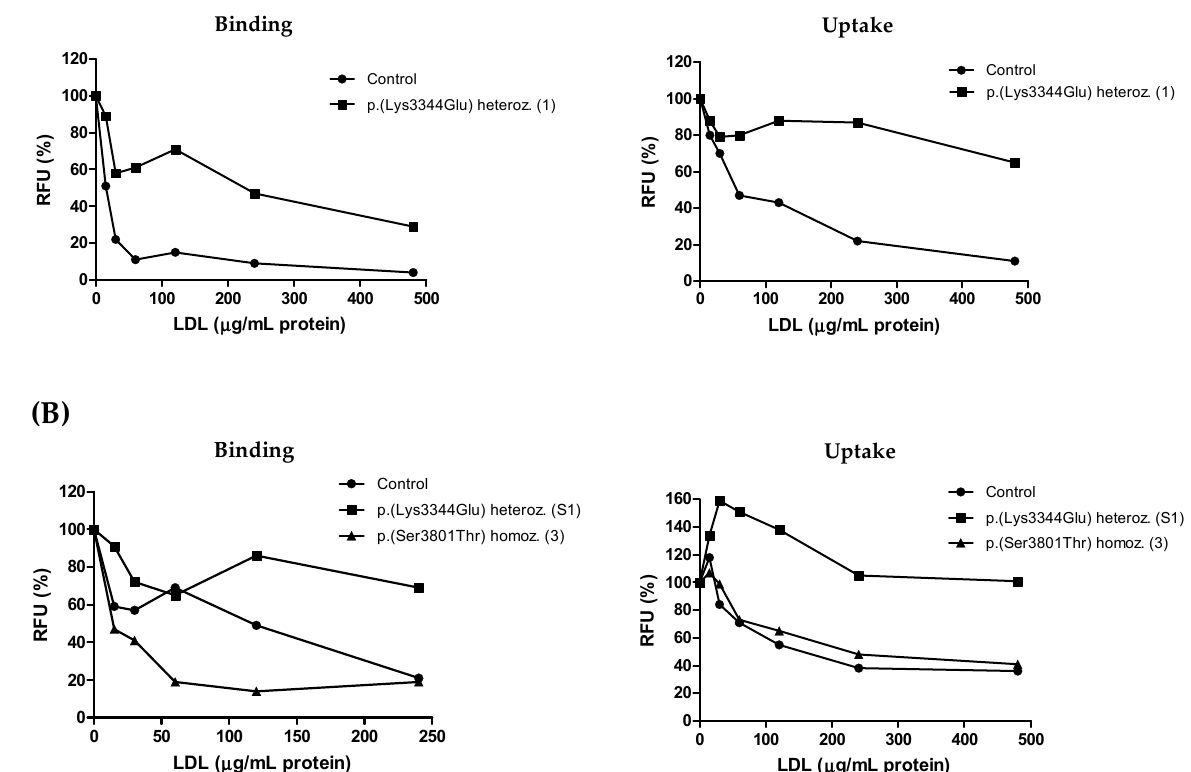
Figure 3. Competitive binding and uptake of LDL in HepG2 cells. ( A ) Ability of LDL from apoB p.(Lys3344Glu) heterozygous patient 1 and the control to compete with DiI-LDL for cellular binding ( p < 0.001) and uptake ( p = 0.014). ( B ) Ability of LDL from apoB p.(Lys3344Glu) heterozygous patient S1, apoB p.(Ser3801Thr) homozygous patient 3 and the control to compete with DiI-LDL for cellular binding (patient S1 vs. control, p = 0.014; patient 3 vs. control, p = 0.023; patient S1 vs. patient 3, p < 0.001) and uptake (patient S1 vs. control, p < 0.001; patient 3 vs. control, p = 0.503; patient S1 vs. patient 3, p < 0.001). Results are expressed as percentage of DiI-LDL binding or uptake in the absence of competitor LDL. The identification of each patient is indicated in brackets (see Table 1 and text). RFU, relative fl uorescence units.